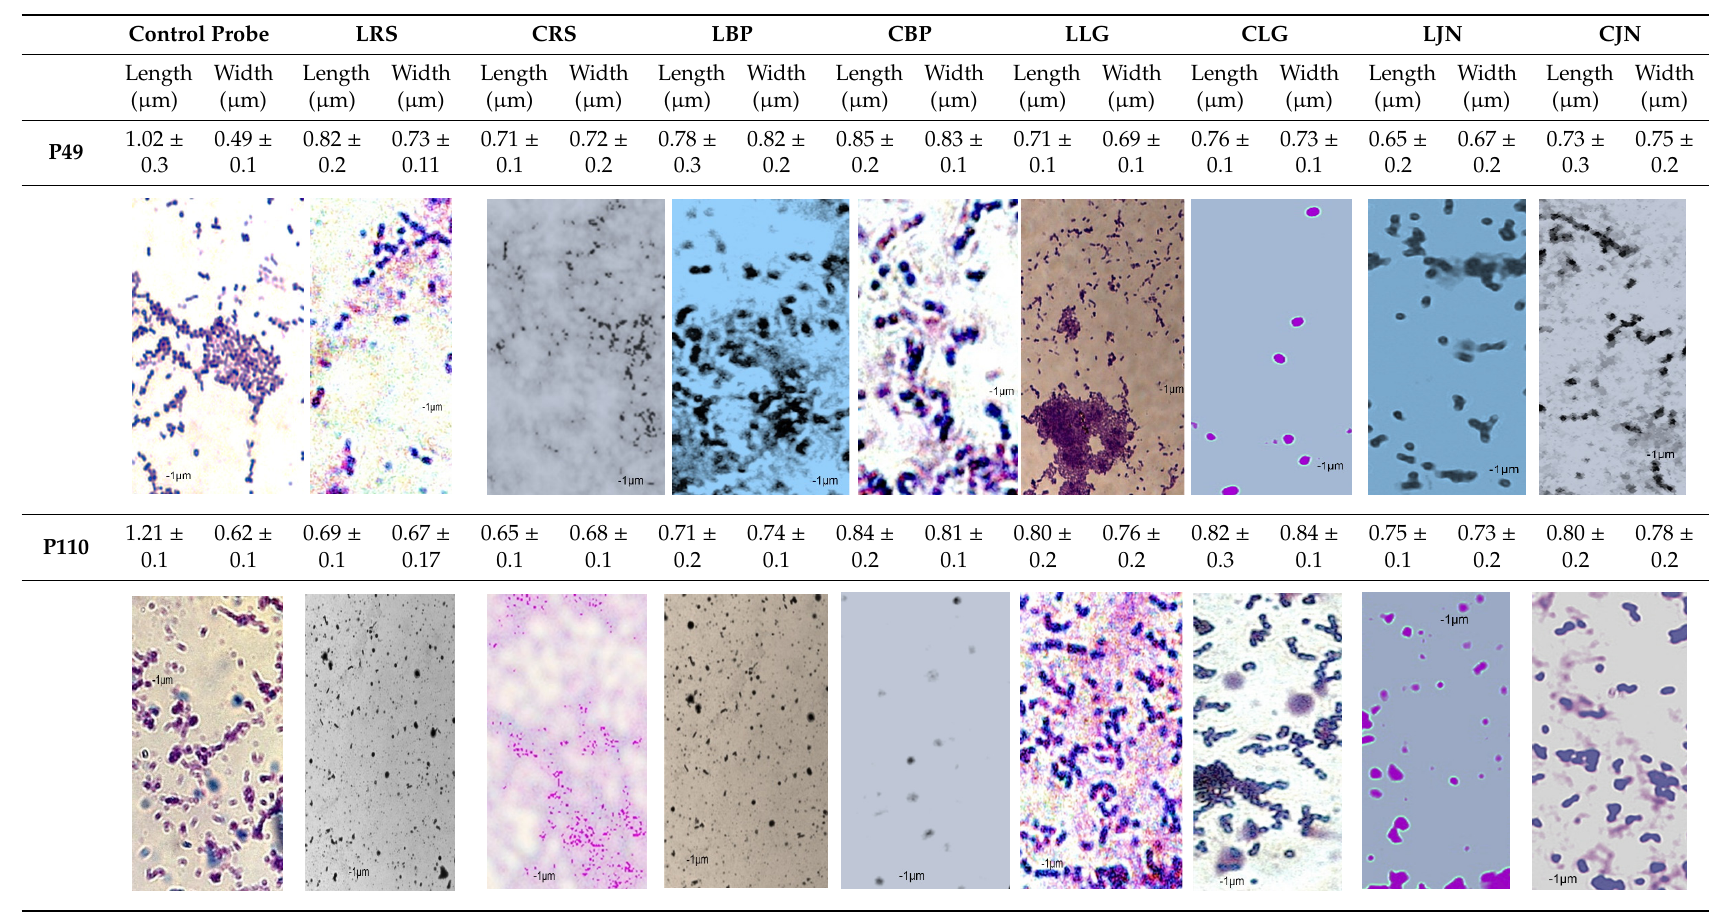
Table 5. Cells’ morphological changes under the influence of essential oils. CRS—commercial rosemary oil, LRS—laboratory rosemary oil, CBP—commercial black